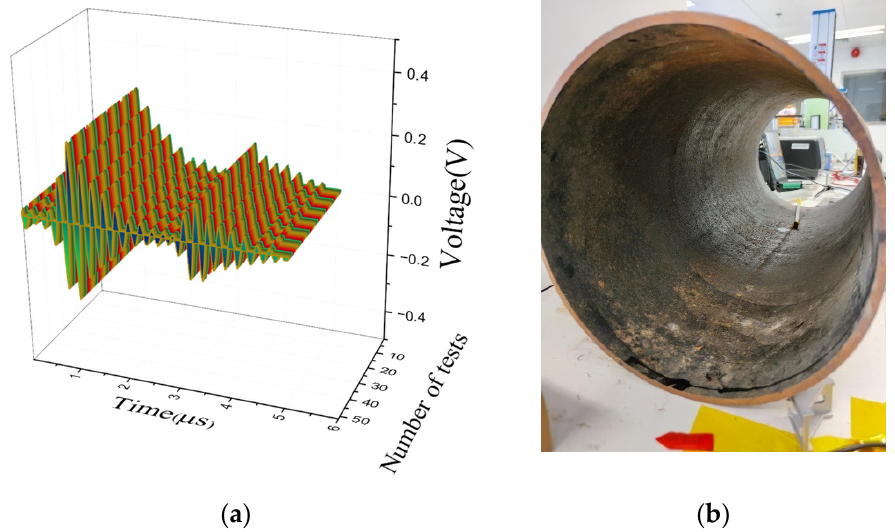
Figure 15. ( a ) 50 sets of data on a steel plate under constant pressure, and ( b ) a photo of a steel pipeline with a wall thickness of 7 mm for verifying the DPTM.